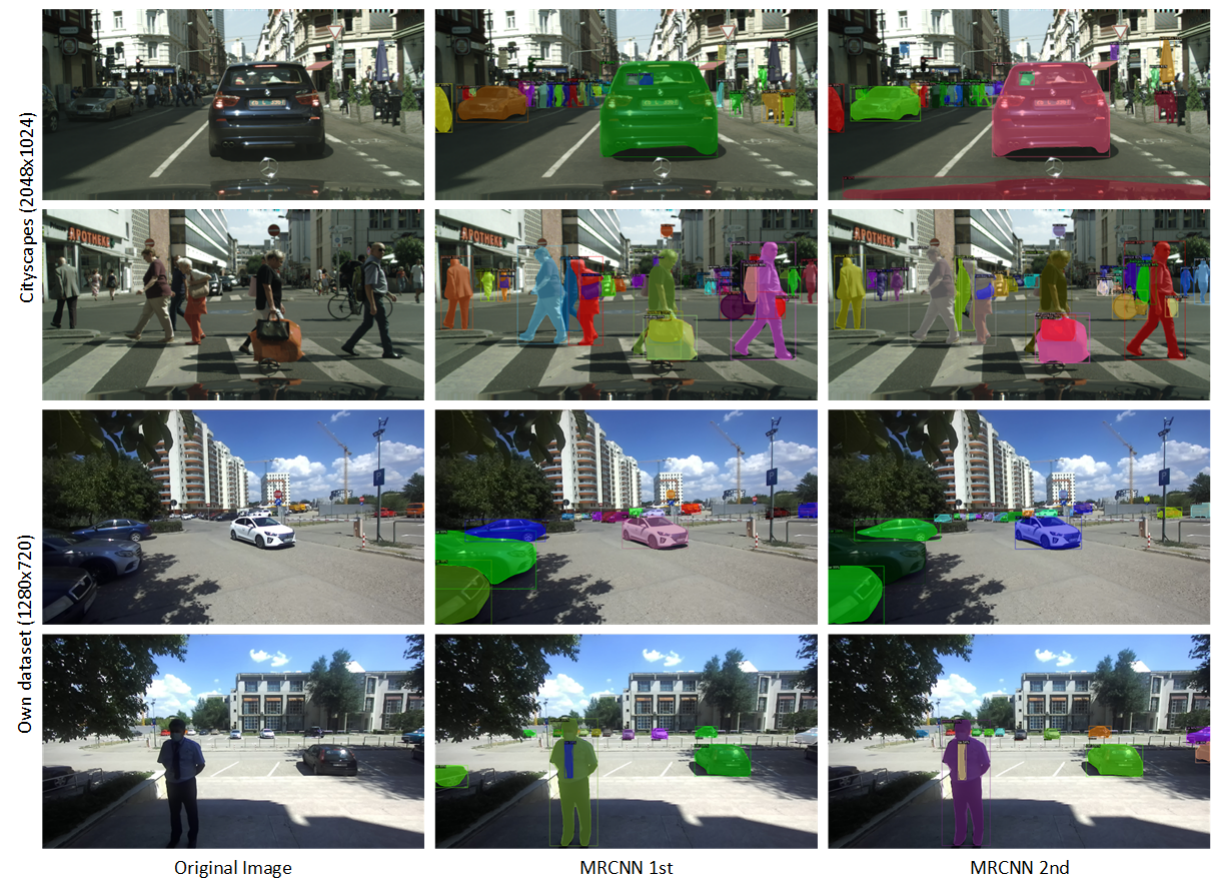
Figure 5. Mask RCNN output prediction examples on Cityscapes and our own images, MRCNN 1st —mask_rcnn_X_101_32x8d_FPN_3x, MRCNN 2nd —mask_rcnn_R_50_FPN_3x